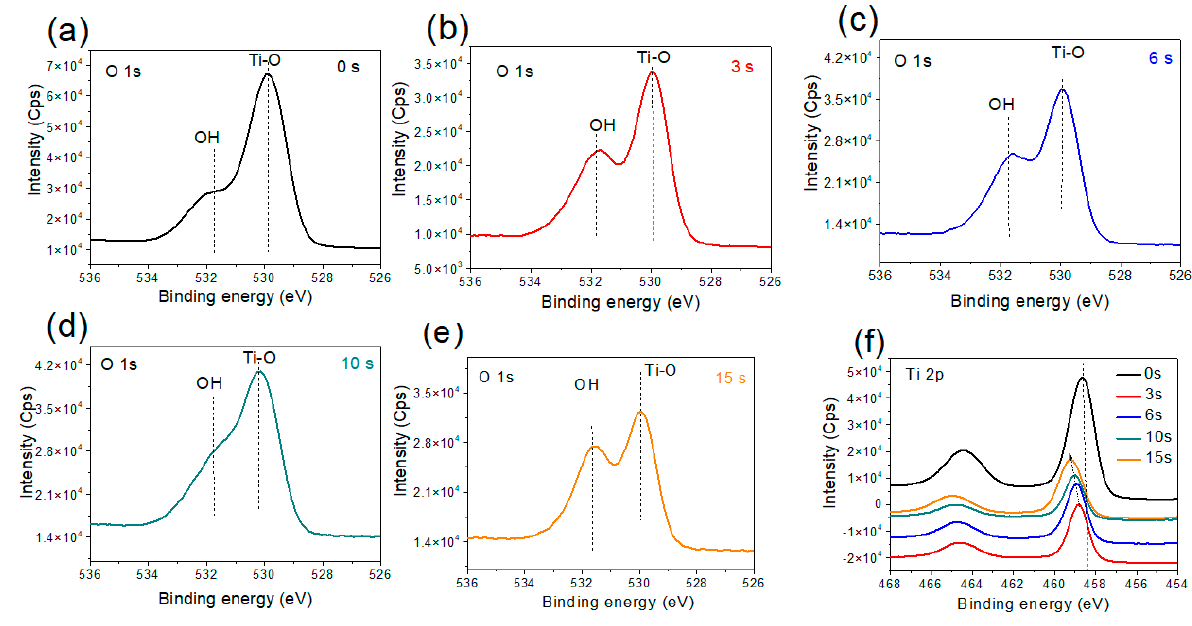
Figure 6. X ‐ ray photoelectron spectroscope data for the 600 °C annealed titania film (TiO 2 ‐ an ‐ nealed600) after Au NP deposition for 0 to 15 s: ( a – e ) O 1s core level spectra, and ( f ) Ti 2p core level spectra.